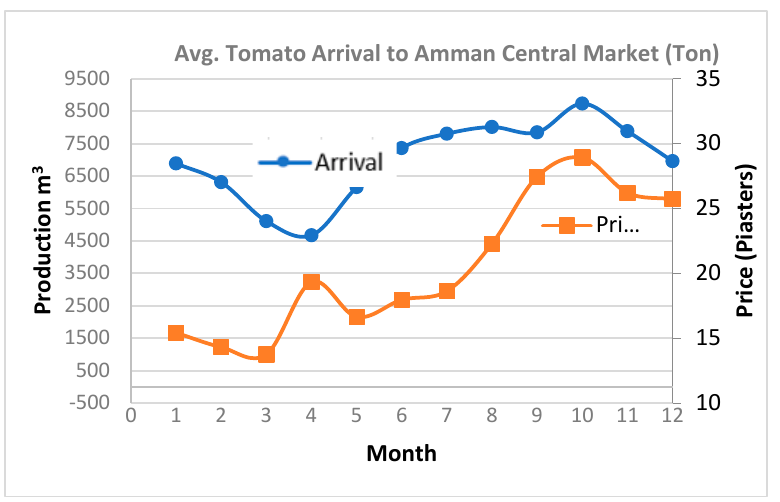
Figure 7. Average tomato production and prices in Amman central market throughout the year.